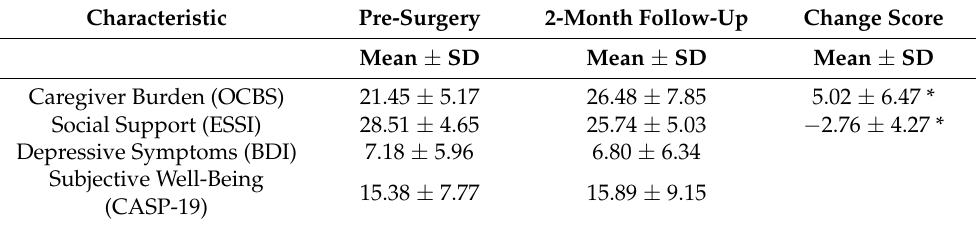
Table 2. Psychosocial, biological, and health variables of the sample ( n =